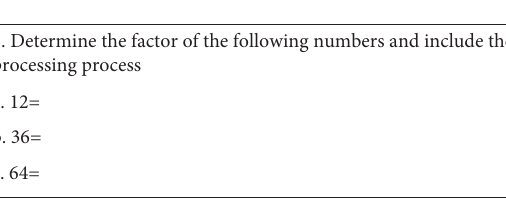
Figure 1: Questions of factor concepts. Table 2: Distribution of students’ answer to question 1.